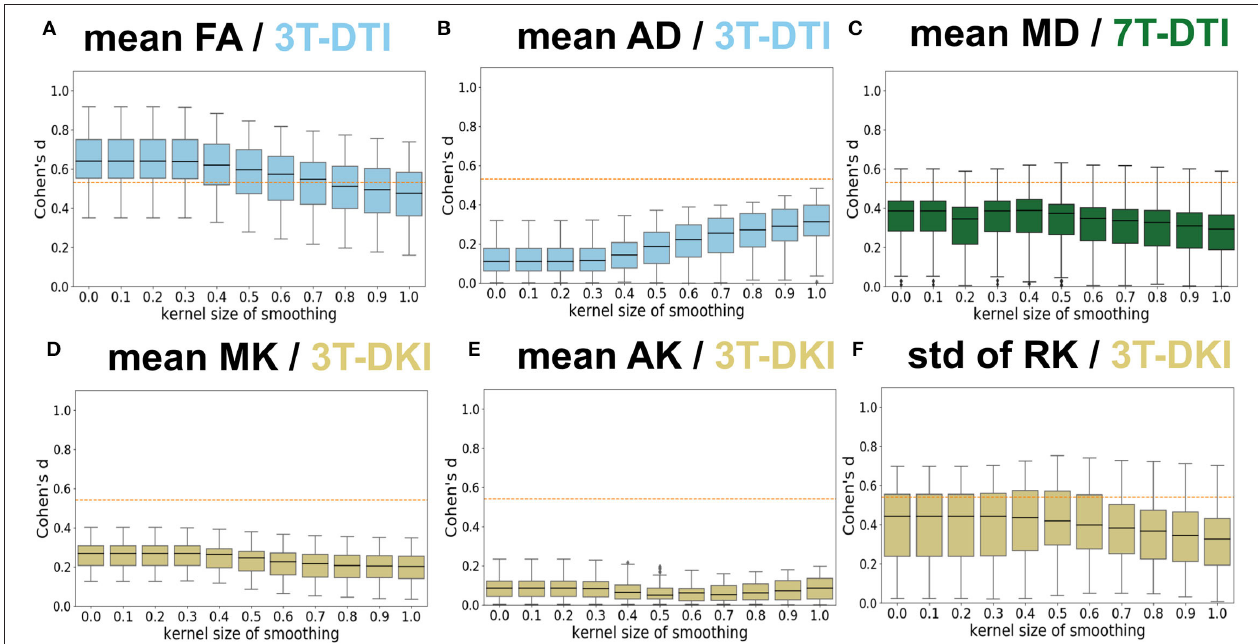
FIGURE 7 | Influence of Gaussian smoothing. Different levels of Gaussian smoothing (sigma, x-axis) were evaluated by the effect size estimates (Cohen’s d , y-axis). (A–F) shows the effect on mean FA from 3T-DTI, mean axial diffusivity (AD) from 3T-DTI, mean MD from 7T-DTI, mean MK from 3T-DKI, mean AK from 3T-DKI, and SD of RK from 3T-DKI. The box plots show Cohen’s d scores among tracts. Overall, smoothing had a detrimental influence on effect sizes. An orange dotted line in each plot defines the threshold in effect size above which the result is considered